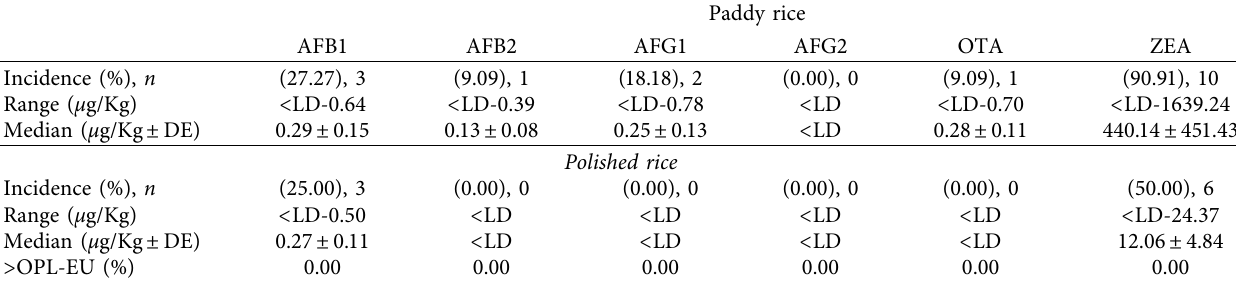
Table 2: Incidence, range, and median of mycotoxins analyzed in rice samples, with shell and polished.